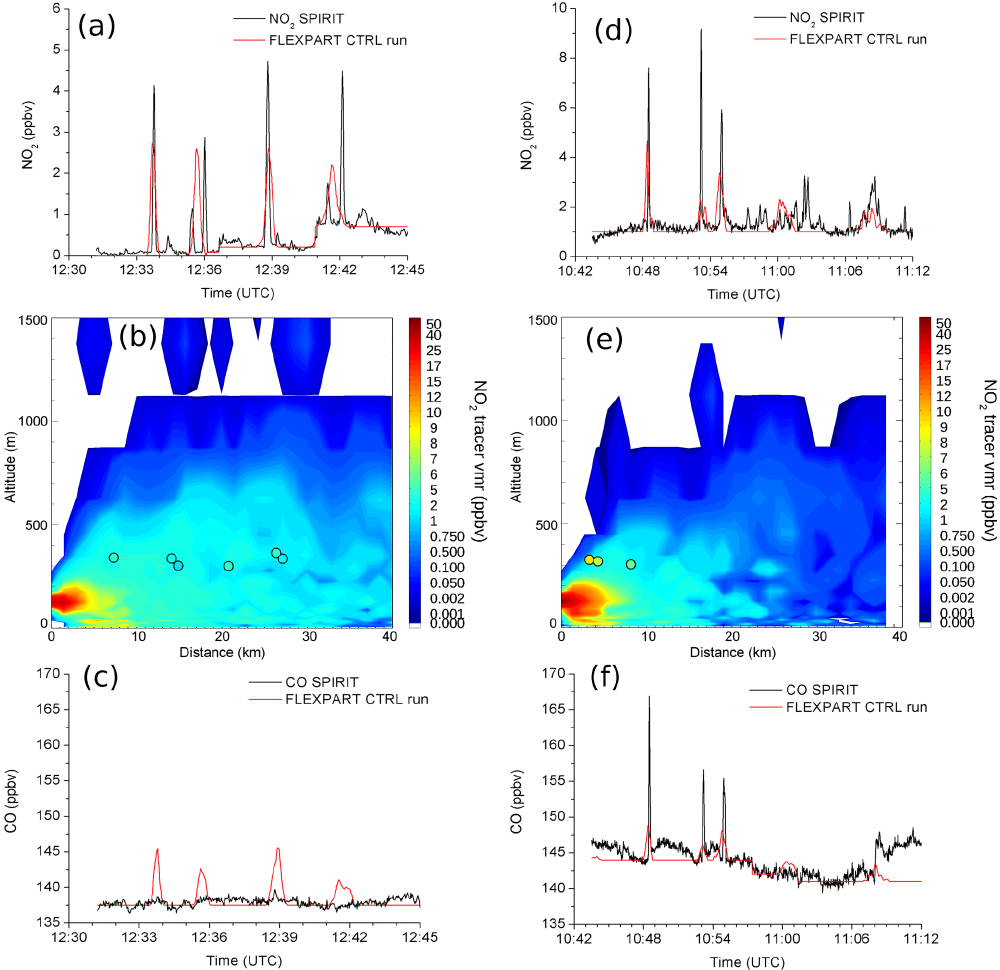
Figure 2. Left column: 10 July. (a) NO 2 concentration as a function of time for SPIRIT measurements (black) and FLEXPART CTRL run simulation (red). (b) Vertical section of the simulated NO 2 concentration (in vmr – volume mixing ratio with units of ppbv) in the plume (CTRL run) as a function of distance from the source and altitude. The coloured circles correspond to the measurement peaks. (c) CO concentration as a function of time for measurements (black) and FLEXPART CTRL run simulation (red). Right column: 14 July. (d) , (e) and (f) similar to (a) , (b) and (c)